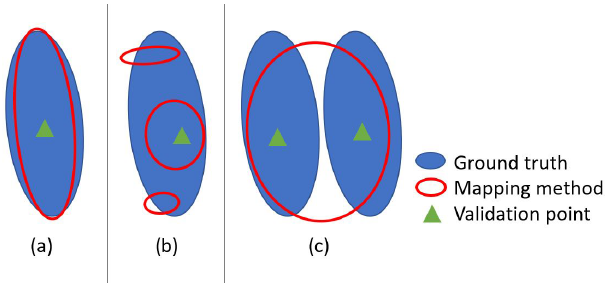
Figure 6. Illustration of a one-to-one join (a) , a one-to-many join (b) and a many-to-one join (c) used to assign the avalanches mapped by the different methods to the validation